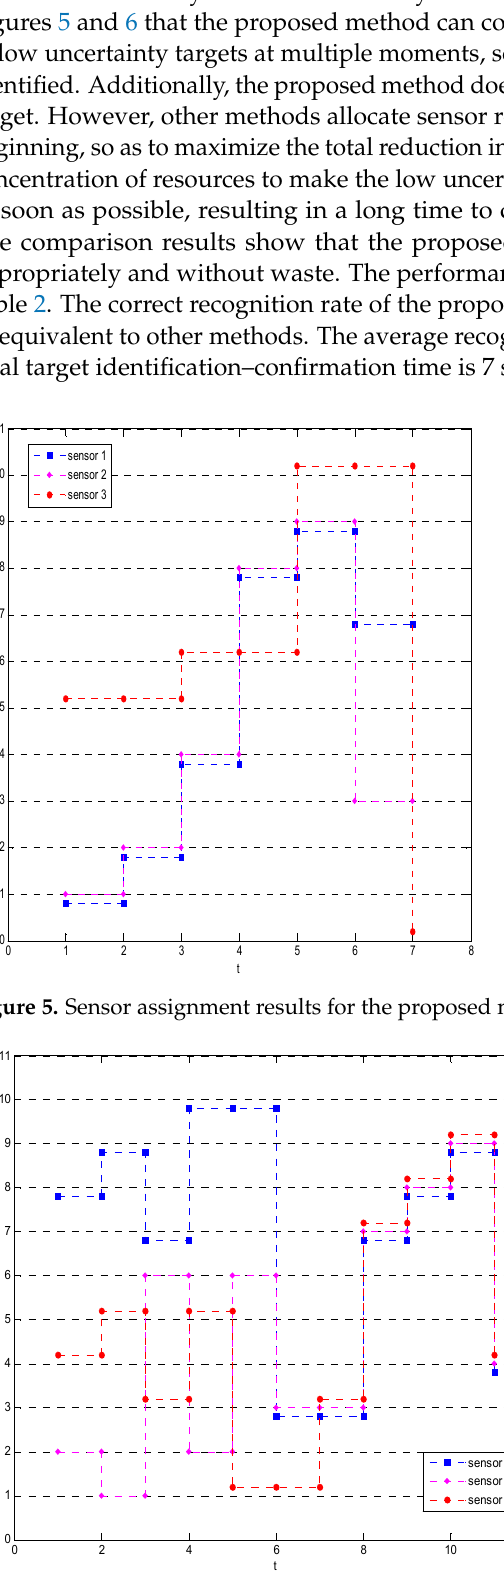
Figure 6. Results of sensor assignment based on information gain method in scenario 3. Table 2. Performance comparison of sensor management algorithms.